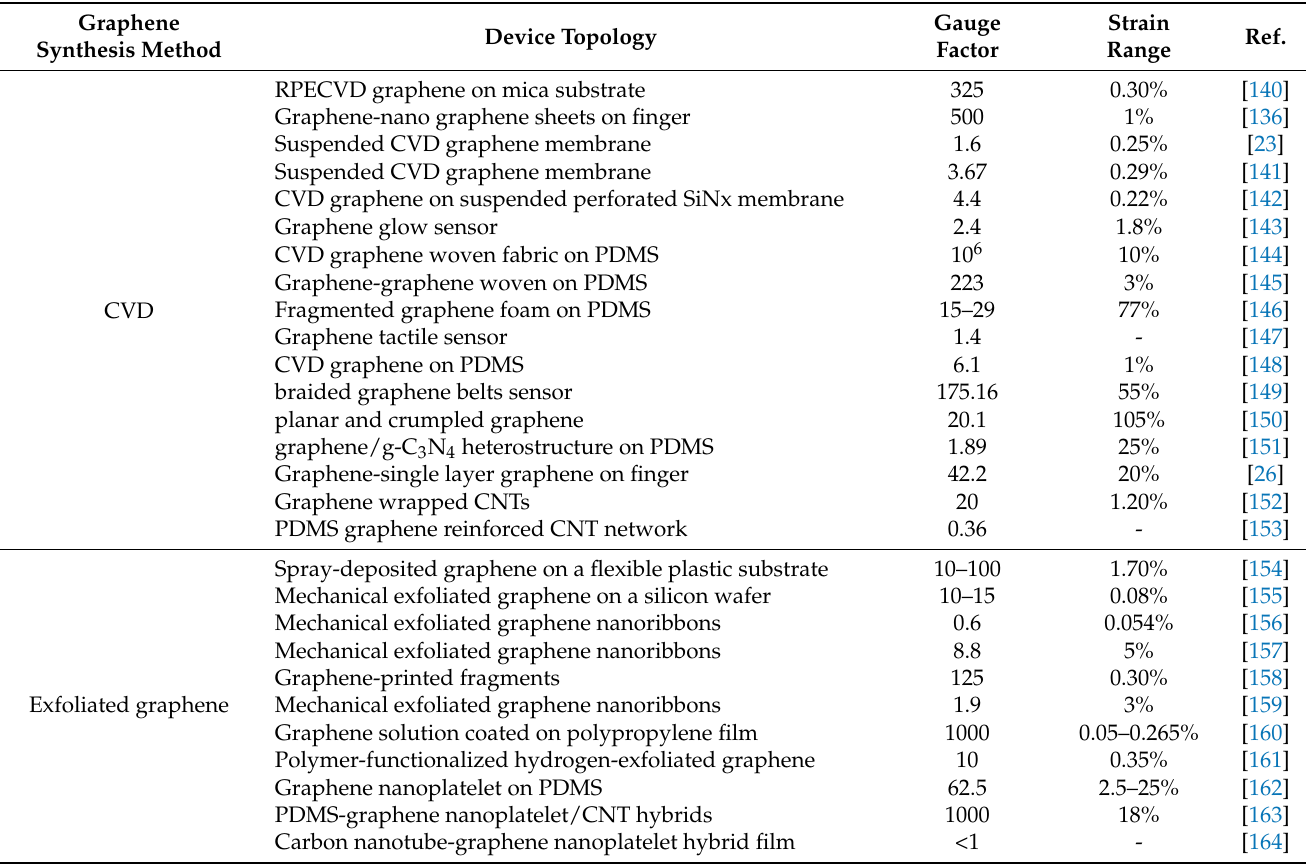
Table 1. Classification of graphene-based strain gauges in terms of the method used to obtain graphene, along with the device topology and performance metrics like gauge factor and strain range. Graphene Synthesis